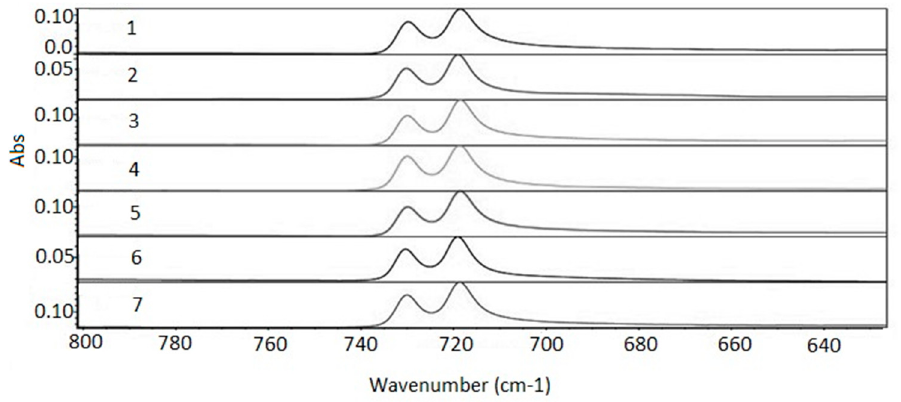
Figure 9. Absorption spectra region from 620 to 800 cm − 1 . 1—virgin sample; 2—960 h Xenon arc sample; 3—1639 h Xenon arc sample; 4—2160 h Xenon arc sample; 5—960 h UV fluorescent sample; 6—4380 h UV fluorescent sample; and 7—8760 h UV fluorescent sample.